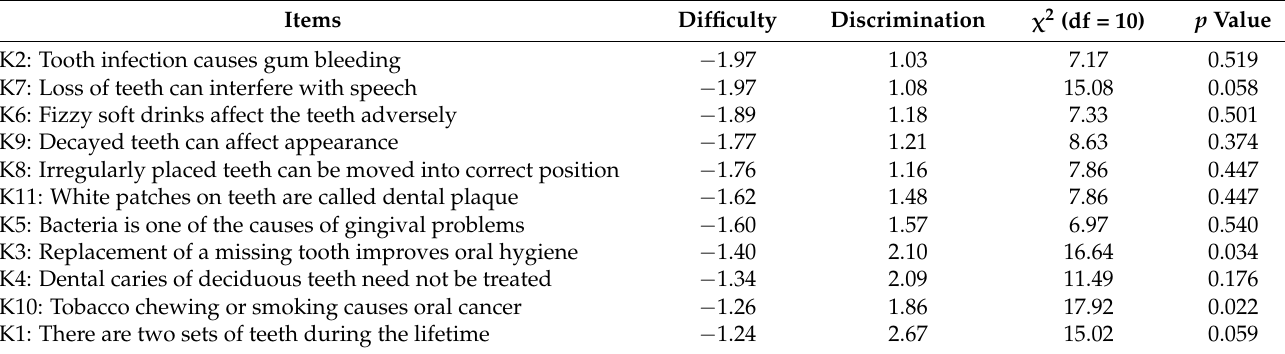
Table 4. Table 4. Result of EFA for knowledge-based questionnaires.